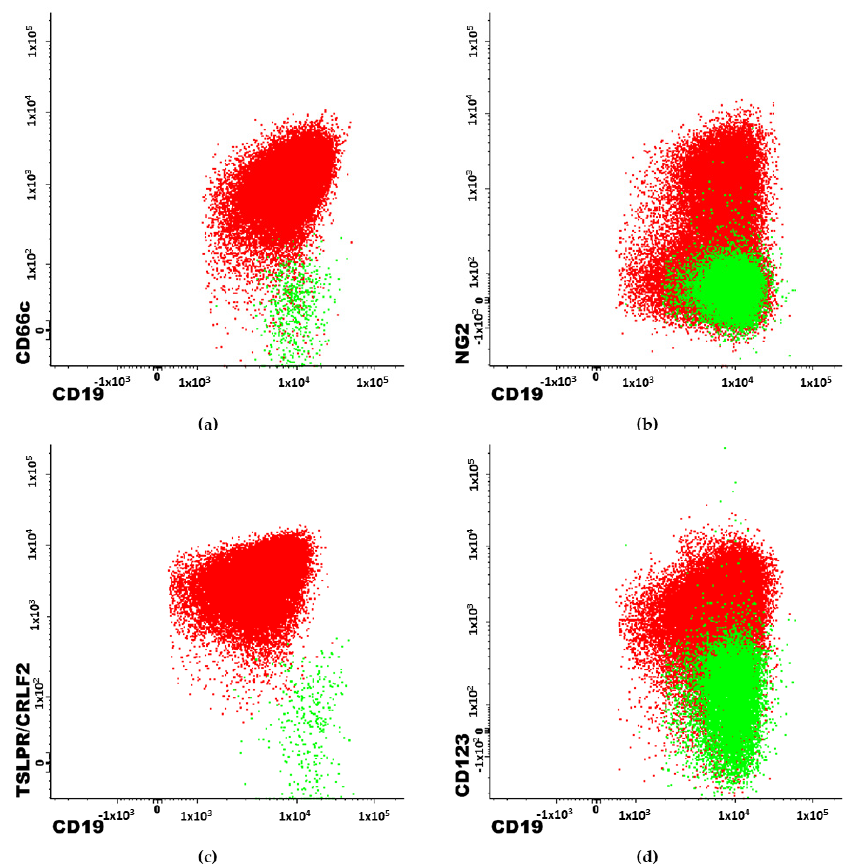
Figure 1. 2-dimendional dot-plots obtained with Flow Cytometry. Examples of immunophenotypic features of patients with BCP-ALL. Red population represents blast cells. Highlighted in green are the normal B-cells. ( a ) patient with Philadelphia chromosome. ( b ) patient with KMT2A gene rearrengement. ( c ) patient with TSLPR/CRLF2 antigen overexpression (Ph-like associated feature). ( d ) patient with hyperdiploidy.